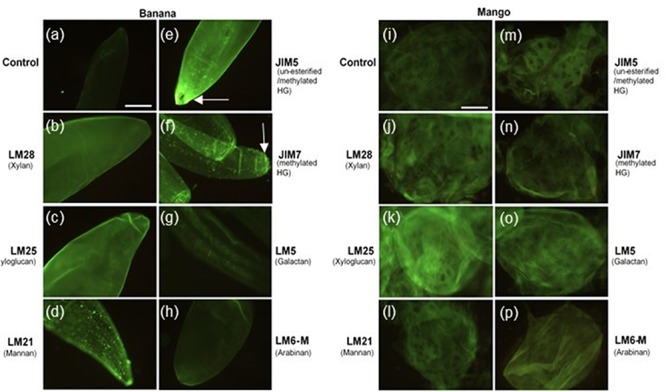
Banana (a–h) and mango (i–p) cells labeled with LM28, LM25, LM21, JIM5, JIM7, LM5 and LM6-M antibodies observed under fluorescence microscope equipped with blue epifluorescence. Scale bar = 50 μm. Arrows point to labeling at the tips of banana cells.